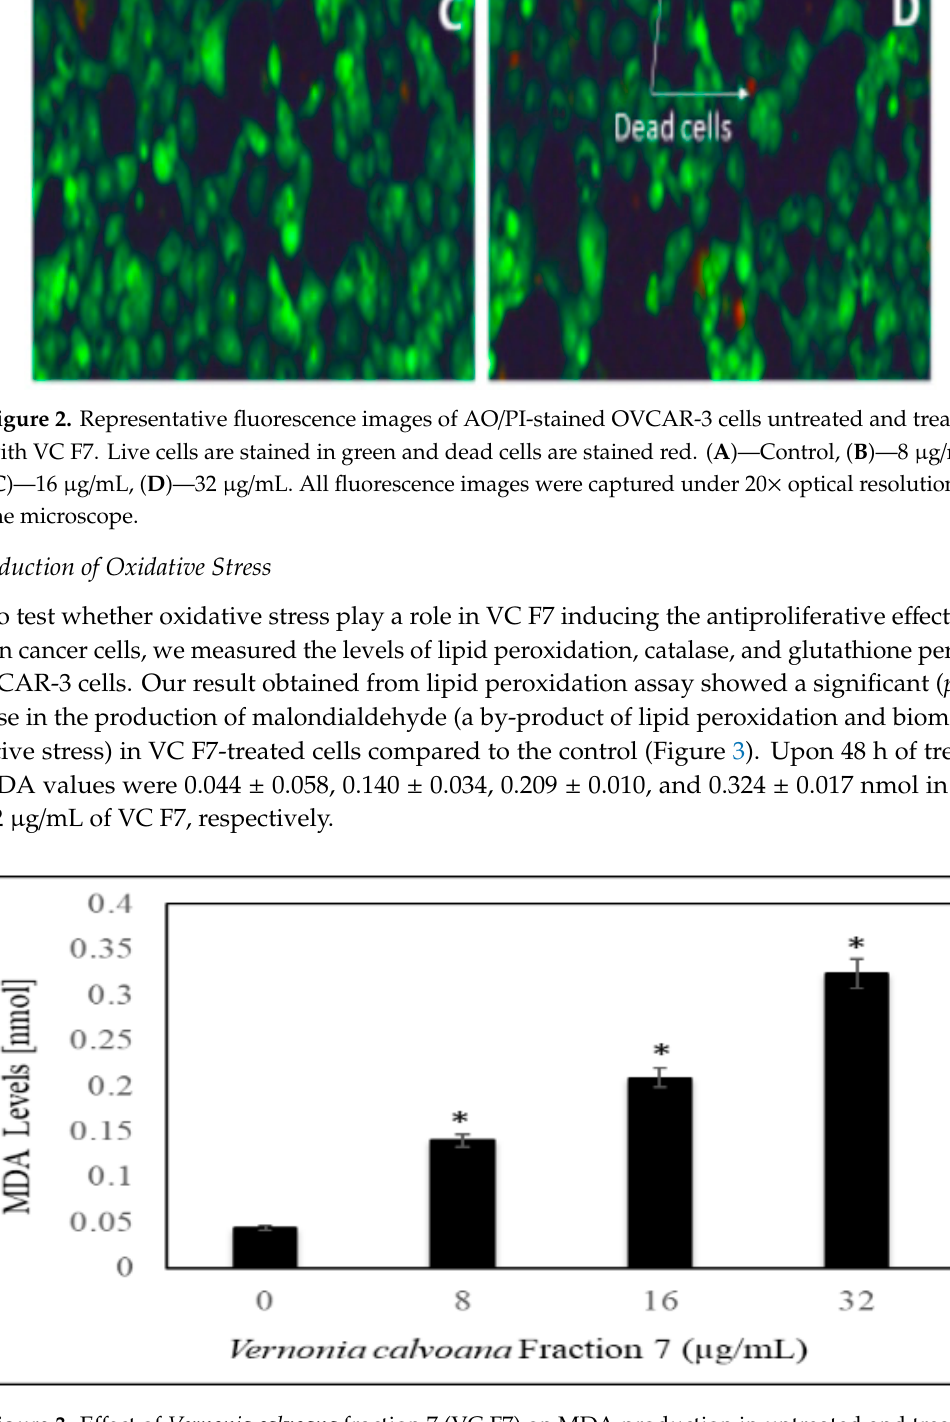
Figure 4. Effect of Vernonia calvoana fraction 7 (VC F7) on catalase activity in untreated and treated OVCAR-3 cells for 48 hours. The doses that were found to be statistically significantly different ( p < 0.05) compared to the control are denoted by (*) according to ANOVA Dunnett. To confirm our observations with the catalase activities, we performed a glutathione peroxidase assay. Data generated from the glutathione peroxidase assay showed a gradual decrease in glutathione peroxidase activity in OVCAR-3 cells treated with VC F7 compared to the vehicle control (Figure 5).